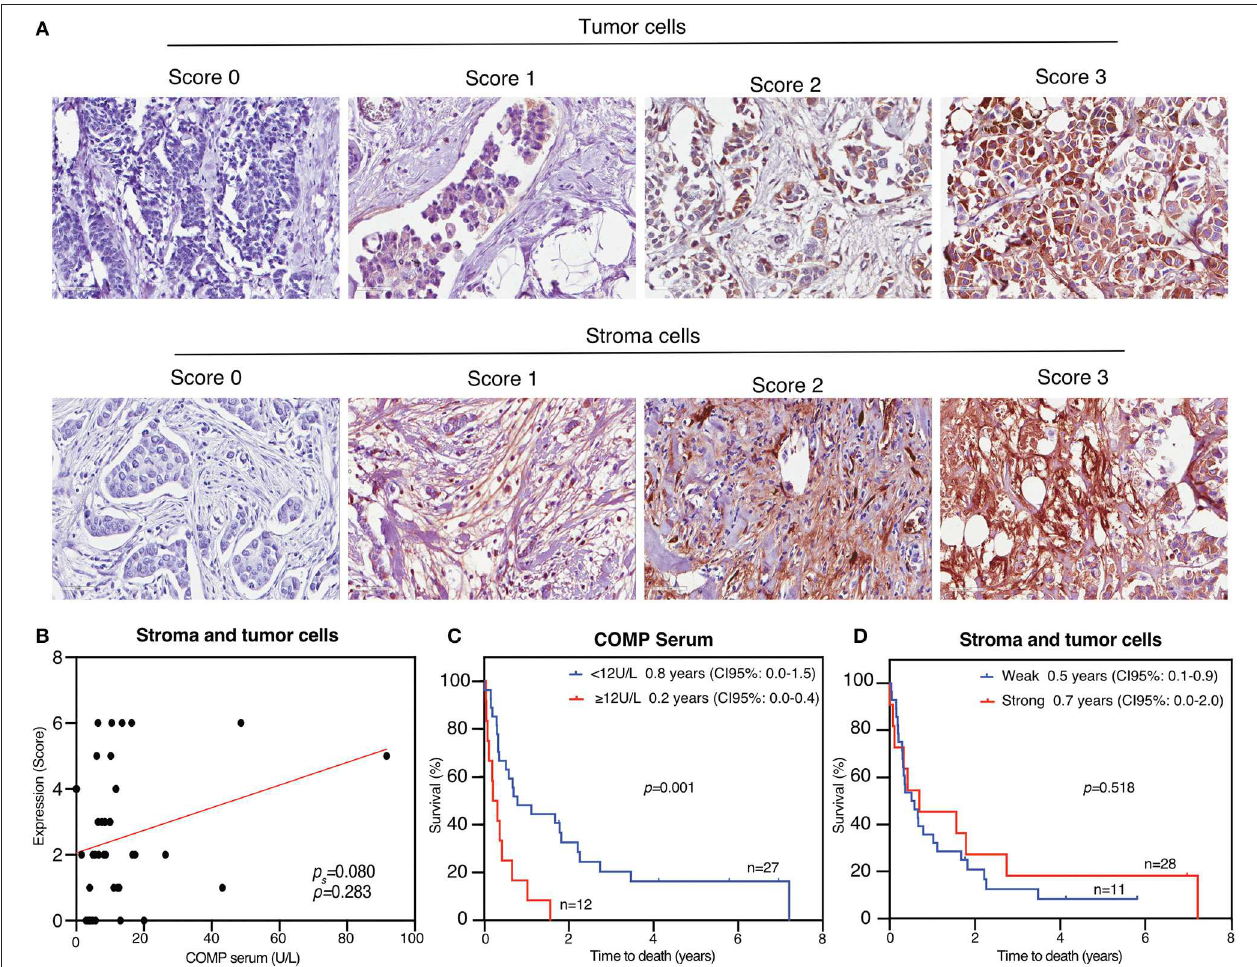
FIGURE 1 | COMP is expressed in breast cancer and can be measured in patient sera, which correlates with poor survival. (A) Biopsies from 39 metastatic breast cancer patients were stained for COMP and the intensity of the staining in tumor cells and stroma was scored separately. Representative pictures for each score were taken at 40X magnification. (B) The scores were grouped into weak (scores 0–2) and strong (score 3) COMP expression. Correlation between level of COMP in sera and cumulative score for immunohistochemical signal in stroma and tumor cells applying the Spearman rank correlation. (C) High serum COMP ( ≥ 12 U/L) are correlated with shorter overall survival (OS). (D) Strong COMP expression in stroma and tumor cells was not significantly associated with decreased OS. Kaplan-Meier analyses with Breslow’s test was used in (C,D) , p < 0.05 were considered significant and survival is presented as the